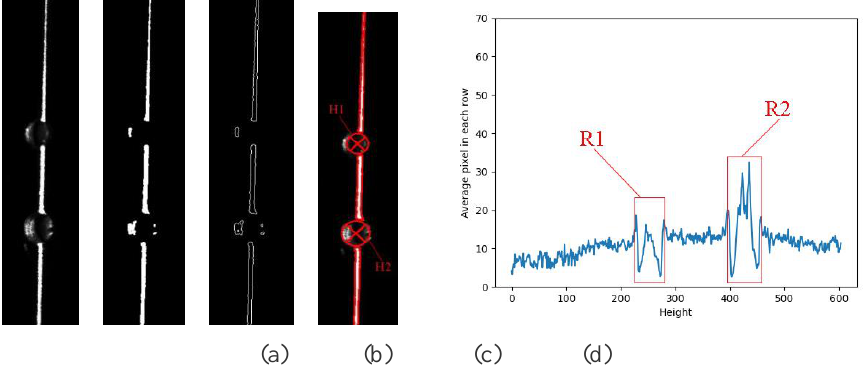
Fig. 5. Image processing for laser line. Fig.6. Specialized histogram of ROI of original